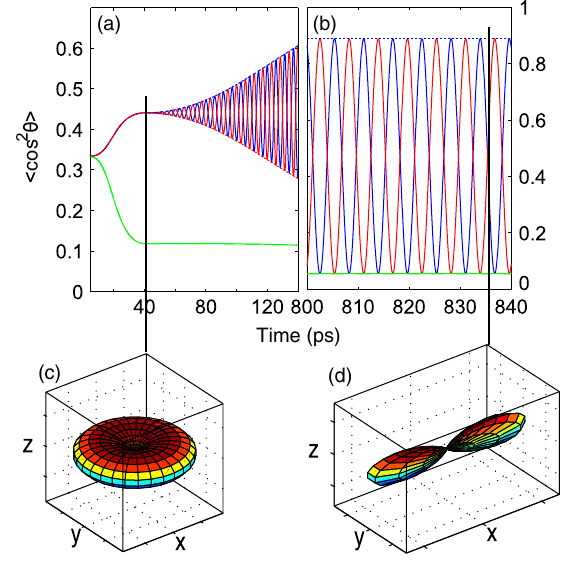
FIG. 1. h cos 2 (cid:2) x i (blue), h cos 2 (cid:2) y i (red), and h cos 2 (cid:2) z i (green) (see text) for (a) short times and (b) long time in the laboratory (solid lines) and the rotating frame (dashed lines). (c) shows the oblate distribution formed by the first pulse at t ¼ 40 ps . (d) shows the prolate distribution in the rotating frame at time t (cid:1) 840 ps . In (c) and (d), the composite laser field polarization q ffiffiffiffiffiffiffi U 0 ¼ 5 : 73 , (cid:1) ¼ 1 : 5 B , is along the x axis. For this calculation, @ I (cid:1) 2 40 ps , (cid:3) 800 (cid:3) 1 ¼ 2 ¼